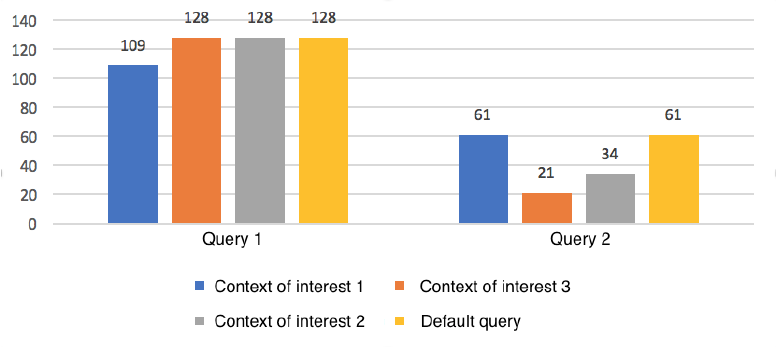
Figure 17. Results of query